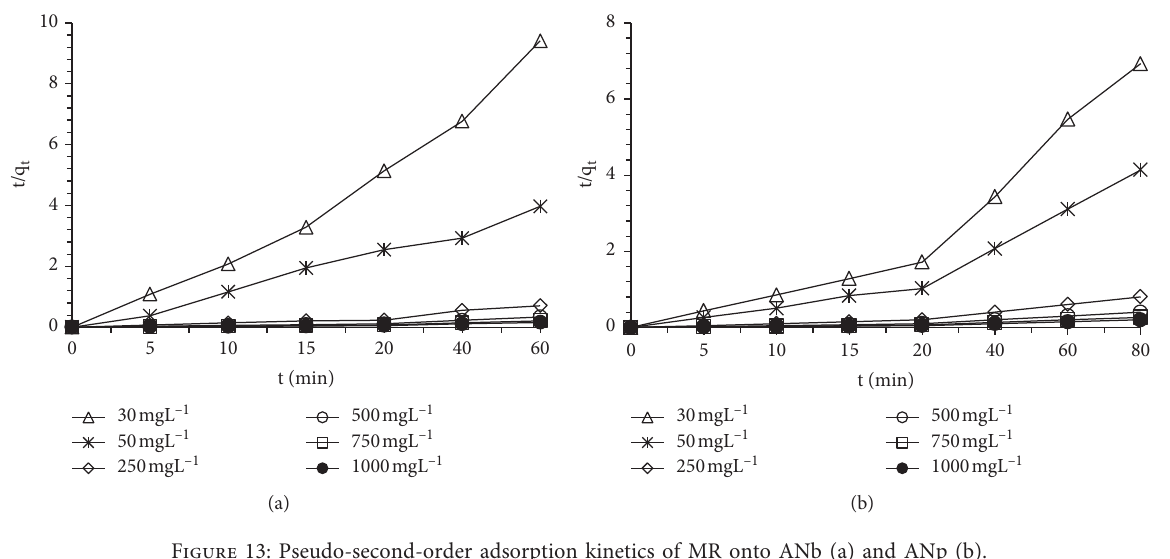
Figure 13: Pseudo-second-order adsorption kinetics of MR onto ANb (a) and ANp